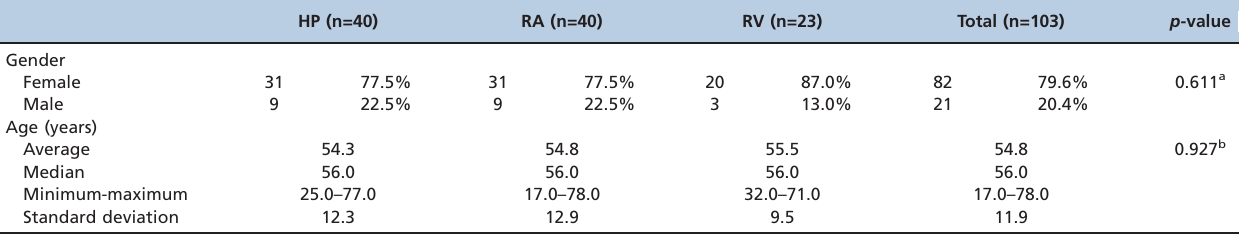
Table 1 - General characteristics of the individuals in each group.